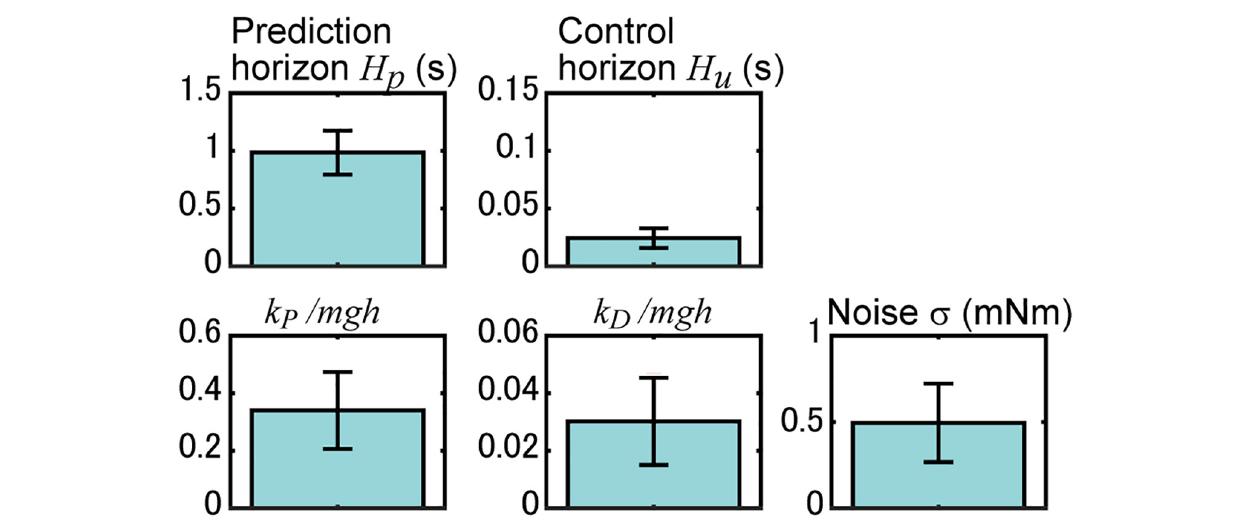
FIGURE 6 | Identified parameters of the proposed model. Results for the prediction horizon H p , control horizon H u , MTP stiffness k P , MTP viscosity k D , and noise magnitude σ are shown. Here, the results of MTP stiffness and viscosity are normalized with m body mass, g acceleration of gravity, and h length from MTP joint to CoM. Blue bars and their error bars represent the average and standard deviation of the identified results for 18 experimental sequences of